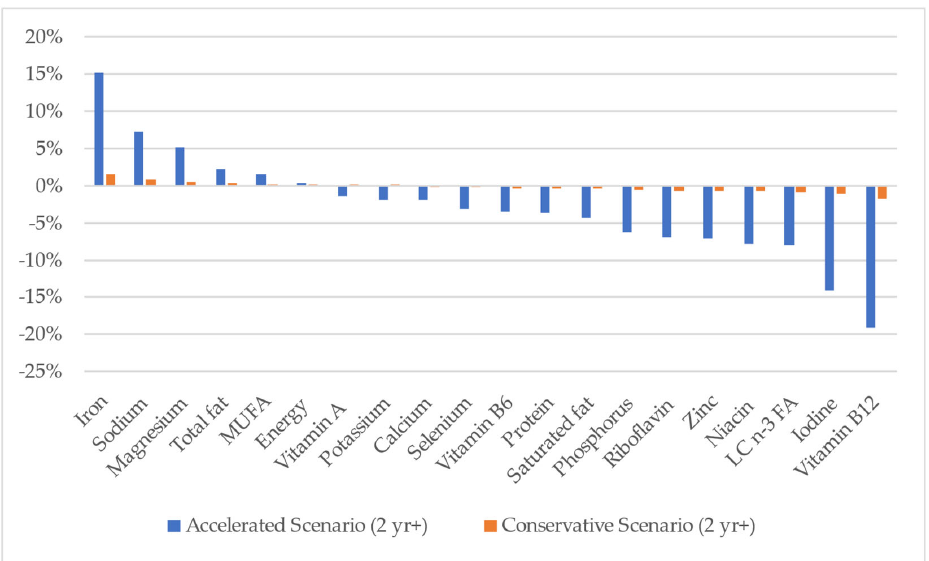
Figure 1. Estimated percentage change 1 in mean daily intake of ‘Key Nutrients’ for modelled Combined Meat and Milk Scenarios for the Australian population (2 years and over). 1 Compared with Base Case; MUFA, monounsaturated fat; LC n-3 FA, long-chain omega-3 fa tt y acids. The predicted impact on the mean nutrient intake of substituting both plant-based ‘meat’ for animal-source meat and plant-based ‘milk’ for dairy milk (combined Acceler- ated Meat and Milk Scenario) for various population groups are shown in Table 3. In the population groups considered (young children, young women, young men and older adults), there was a theoretical decline in the intake of n-3 long-chain fa tt y acids (of 7– 14%), ribo fl avin (6–10%), niacin (5–13%), vitamin B12 (16–31%), iodine (12–36%), phos-